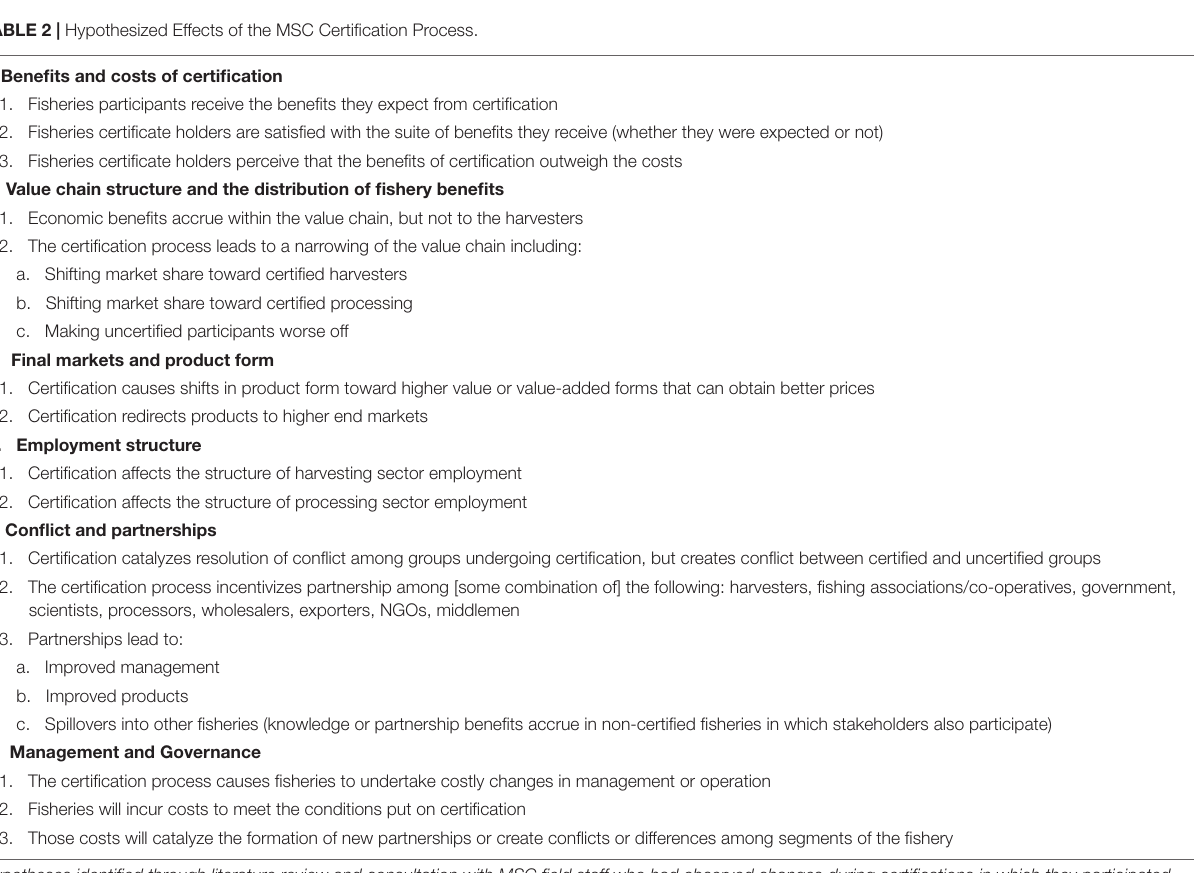
TABLE 2 | Hypothesized Effects of the MSC Certification